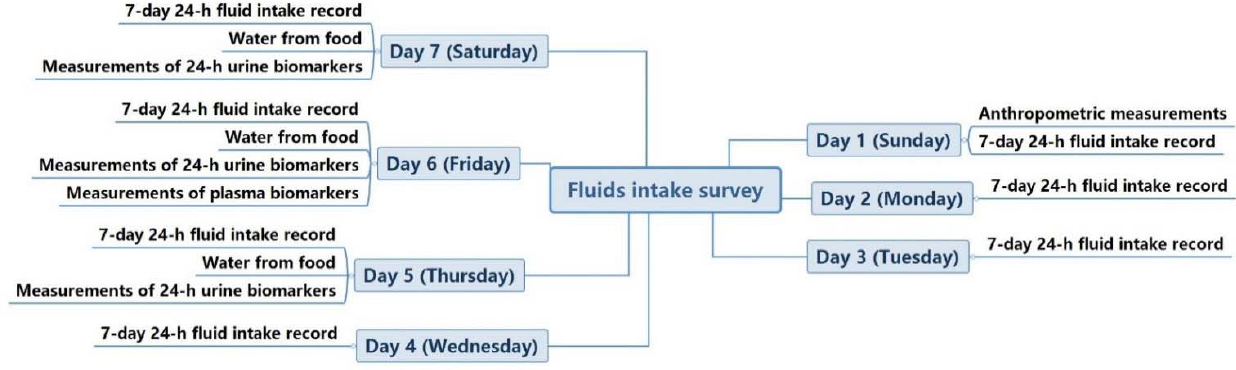
Figure 1. Study procedure.